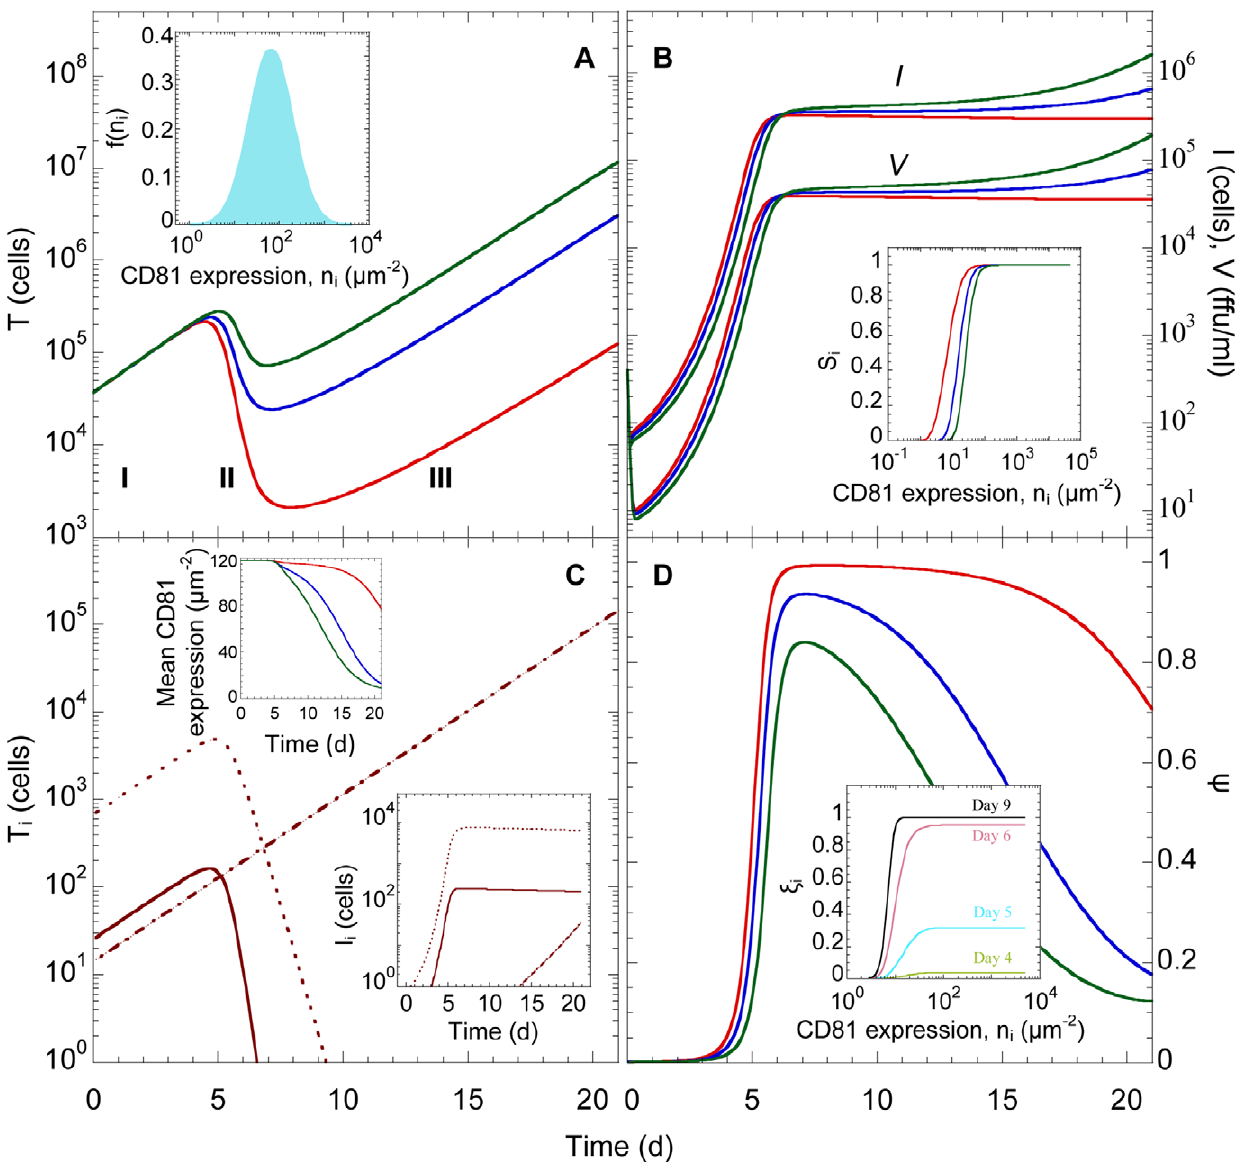
Figure 2. Model predictions of HCV viral kinetics in vitro. The time evolution of (A) uninfected cells, T , (B) infected cells, I , and viral load, V , (C) uninfected cell sub-populations, T i , and (lower inset) infected cell sub-populations, I i , corresponding to S i & 10 { 5 (dot-dashed line), 0.5 (dotted line) and 1 (solid line), and (D) the total fraction of cells infected, y . The initial CD81 distribution, f n i ð Þ , as a function of the CD81 expression level, n i , is presented in the inset in (A). The three phases of infection are also marked in (A). Inset in (B) shows S i as a function of n i . Upper inset in (C) shows the time evolution of the mean CD81 surface density. Inset in (D) shows the fractions of cells infected in sub-populations with distinct CD81 expression ~ 2 (red line), 4 (blue line), and 6 (green line). In (C) and the levels, j i , at different post-infection times. In (A), (B), (D) and the upper inset in (C), N T C ~ 4 . Other parameter values employed are l ~ 0 : 44d - 1 ; m ~ 1 : 7 | 10 { 4 d - 1 ; d ~ 0 : 011d - 1 ; p ~ 2 : 78ffu : (ml : d) { 1 ; c ~ 23 : 2d { 1 ; inset in (D), N T C b ~ 1 : 2 | 10 { 4 ml : (ffu : d) { 1 ; K D ~ 1 : 7 | 10 { 4 M . Initial conditions are T (0) ~ 3 : 7 | 10 4 cells ; I (0) ~ 0 ; V (0) ~ 400ffu : ml { 1